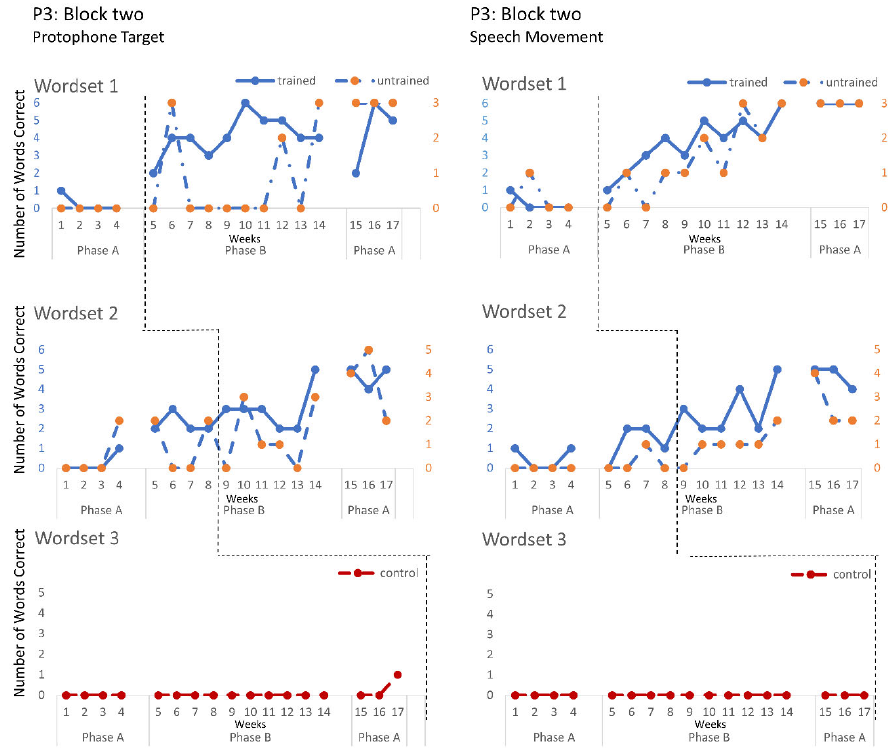
Figure 9. Accuracy of performance on the speech probes as scored for protophone target ( left ) and motor-speech movements ( right ) block two, participant 3.